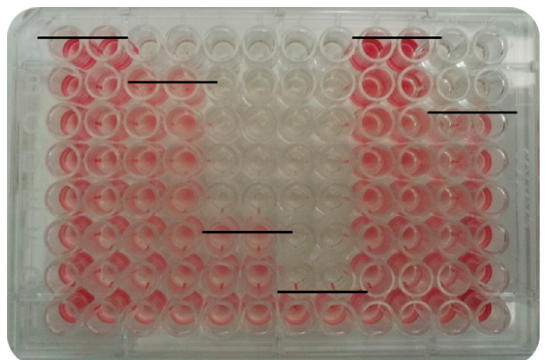
Figure 1. Minimum inhibitory concentration (MIC) determination by microdilution in a 96-well plate. The line indicates the last dilution where bacterial viability was not evidenced. Columns (1–12): different N -alkylimidazolium salts (in duplicate). Rows (A–H): seriated dilutions of each salt (2 - 0.015626 mM)